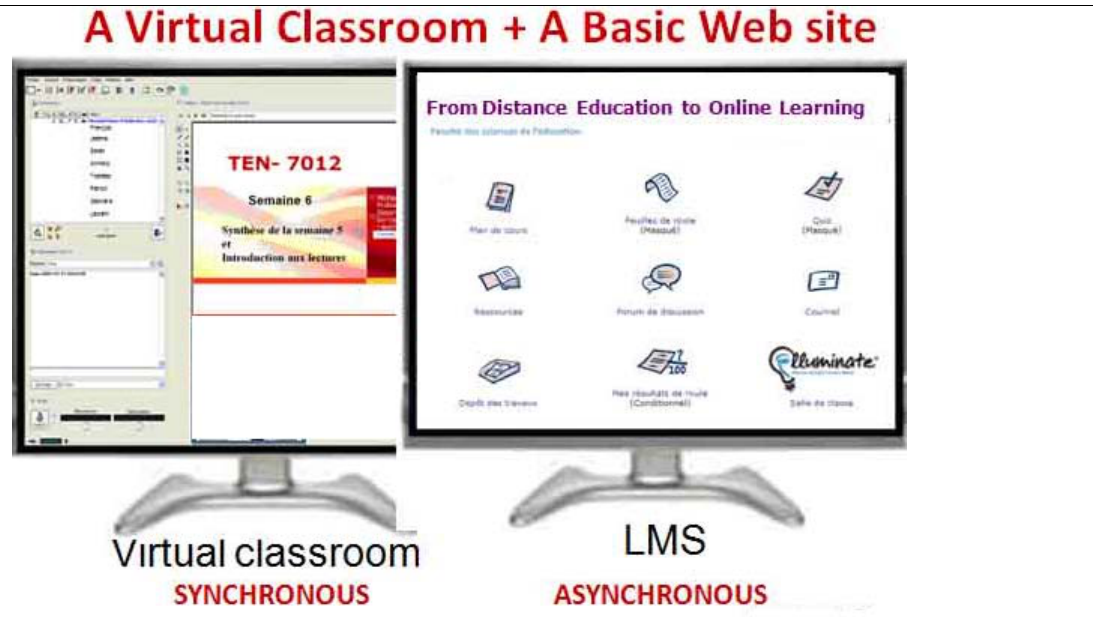
Figure 5 . BOLD, a combined-technology approach to the design and delivery of university graduate